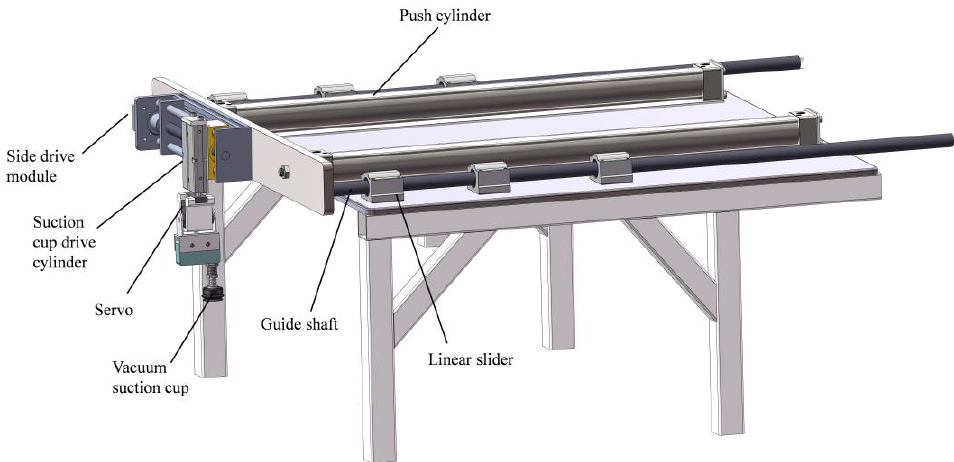
Figure 9. Apple side posture adjustment schematic.